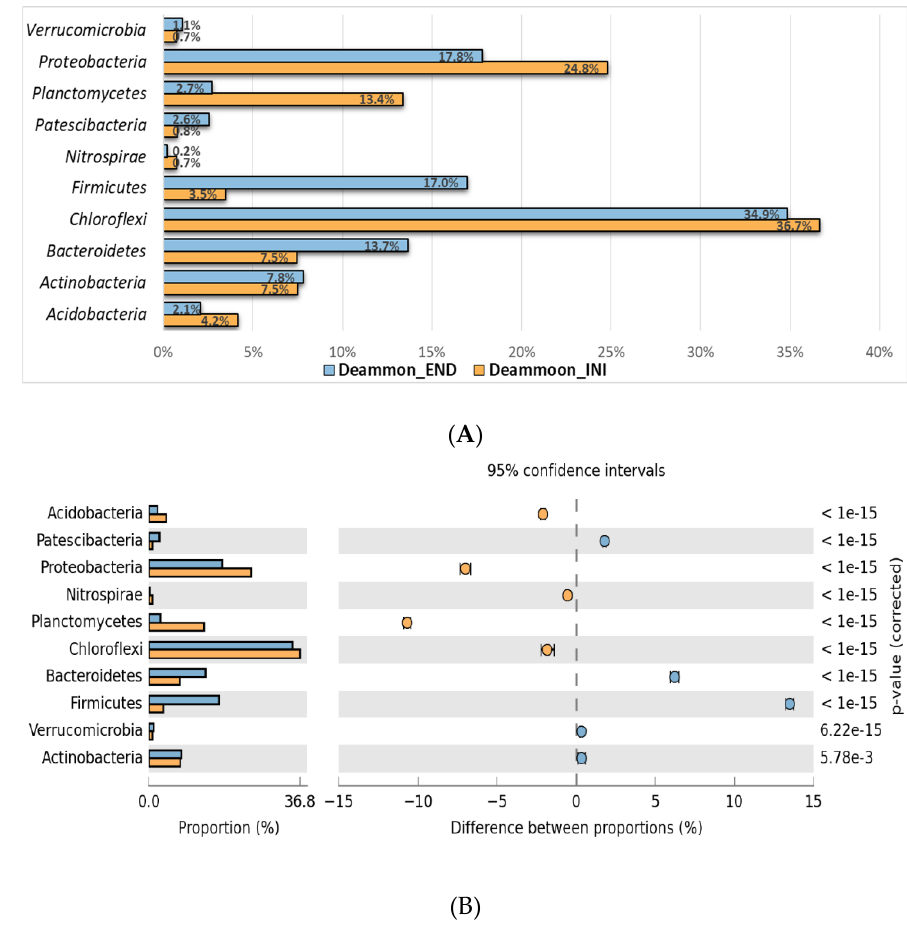
Figure 1. Percent abundances of the quantitatively important (percentage ≥0.7% of the total bacterial community) bacterial phyla in the initial biomass (orange) and biomass after 90 days of continuous carbon addition (blue) (A). The graph (B) obtained with the STAMP software (below), shows the differences between the proportions of sequences in each sample with a confidence interval of 95%. Table 2. Summary of the 16S rRNA gene Illumina NGS analysis.